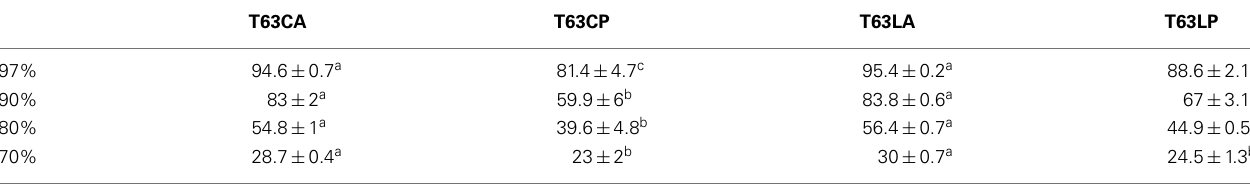
TableA3 |Average of observed OTUs at four different sequences similarities.